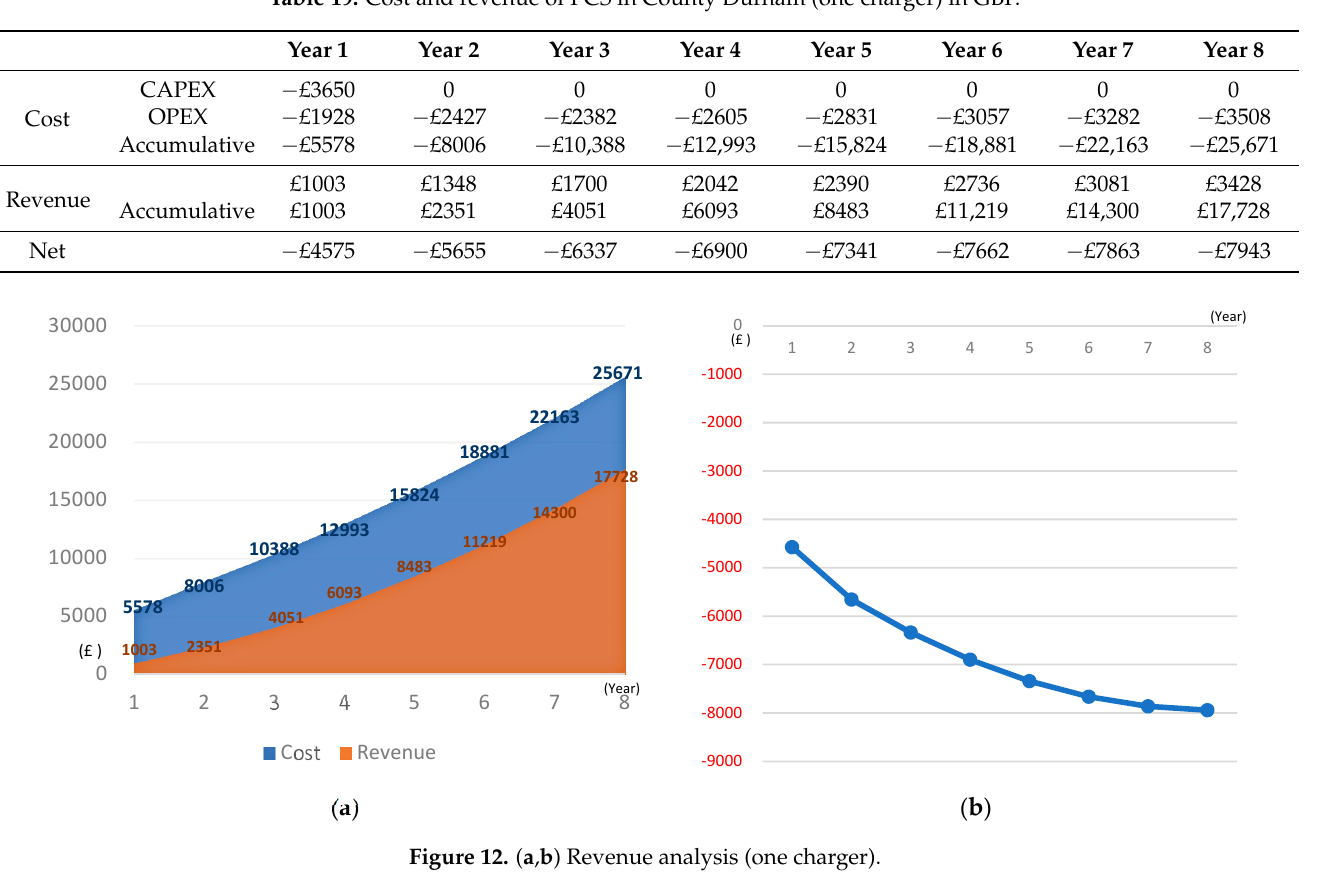
Table 19. Cost and revenue of PCS in County Durham (one charger) in GBP.